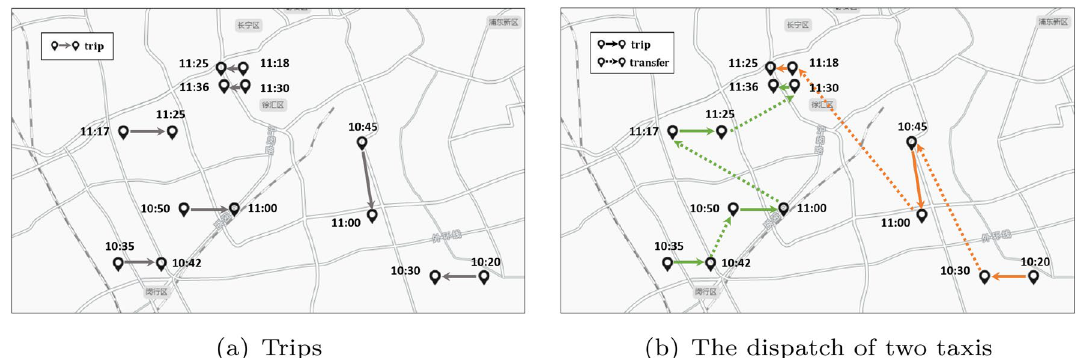
Fig. 21 Trips and the dispatch of